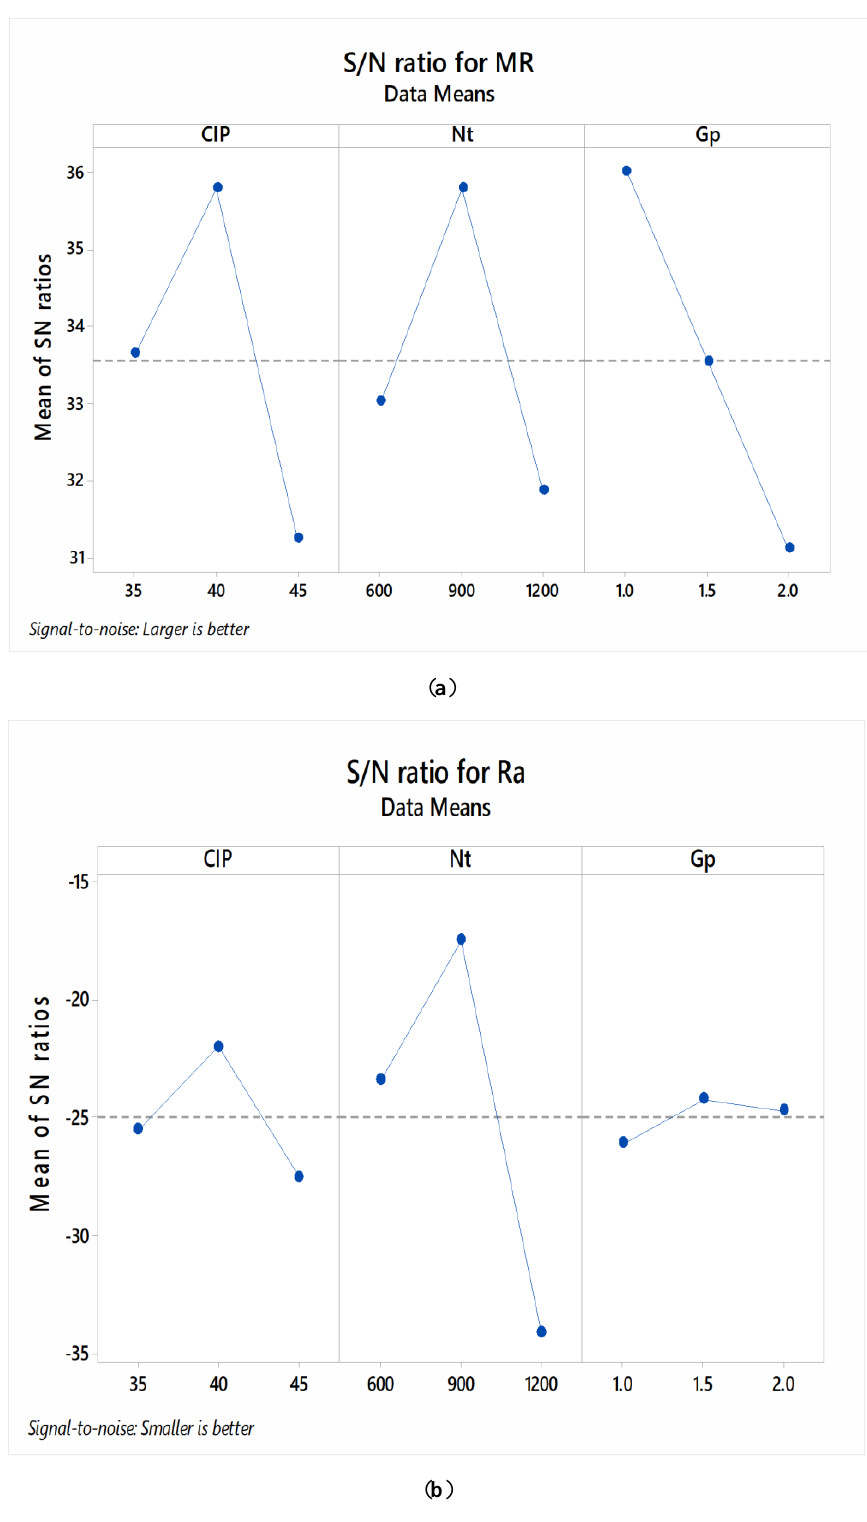
Figure 3. S / N ratio response of the input process parameters on MR ( a ) and Ra ( b Figure 3. S/N ratio response of the input process parameters on MR ( a ) and Ra ( b ).